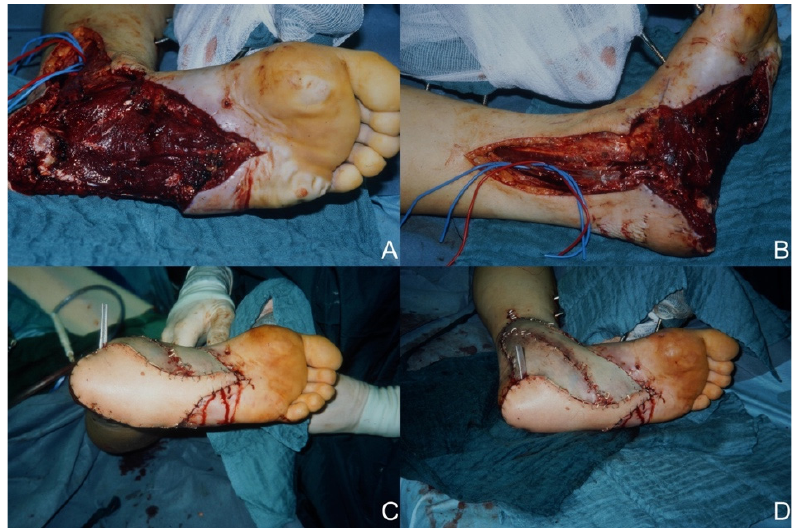
Figure 1. Reconstruction of an extensive foot defect using a latissimus dorsi flap. ( A ) Preoperative defect plantar view. ( B ) Preoperative defect medial view. ( C ) Postoperative plantar view. ( D ) Postoperative medial view.